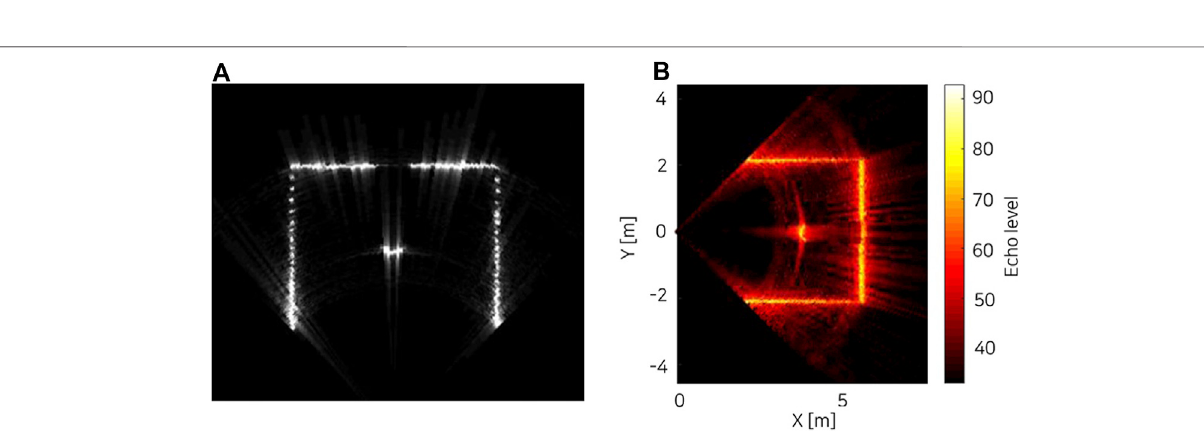
FIGURE 8 | Simulated multibeam echosounder image of a cylinder in a square sonar tank with re fl ectivity (cid:1) 1e-3 [ (A) live-view screenshot in the Gazebo with 11 rays, (B) time-averaged image colorized using MATLAB with 114 rays].